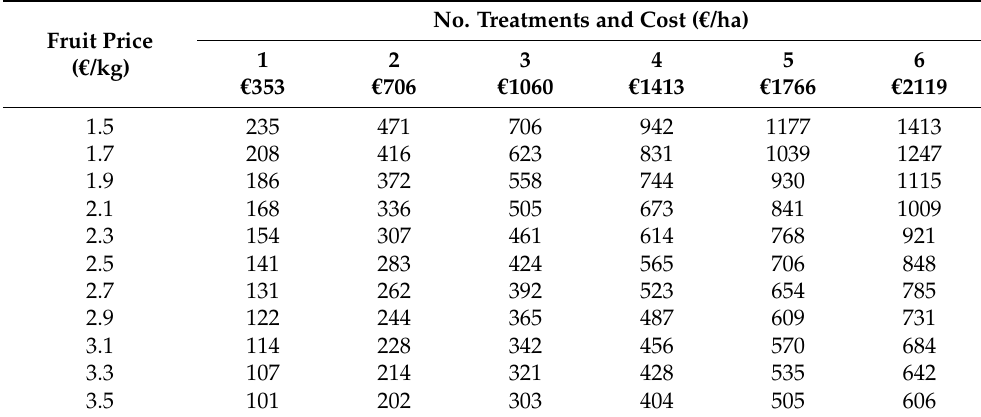
Table 9. Increase of yield/ha necessary to pay for a certain number of phytosanitary sprays. Fruit